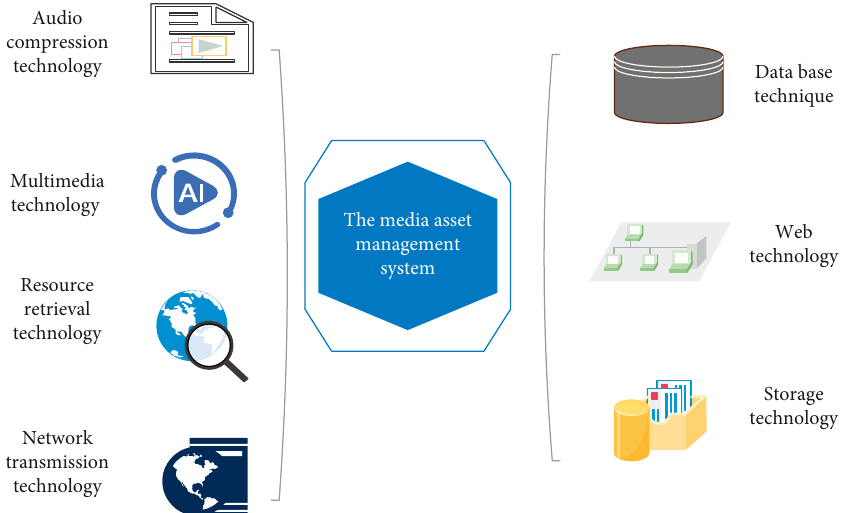
Figure 6: Functional requirements of media resource management system.